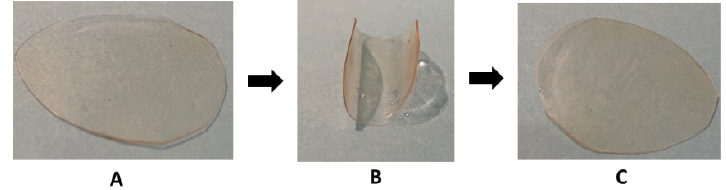
Figure 10. Shape memory cycle for the sample 5050DDM. ( A ): Permanent shape. ( B ): Programmed shape. ( C ): Recovered shape.